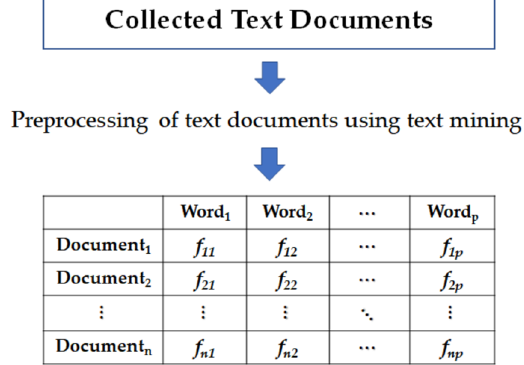
Figure 1. Document-word matrix.